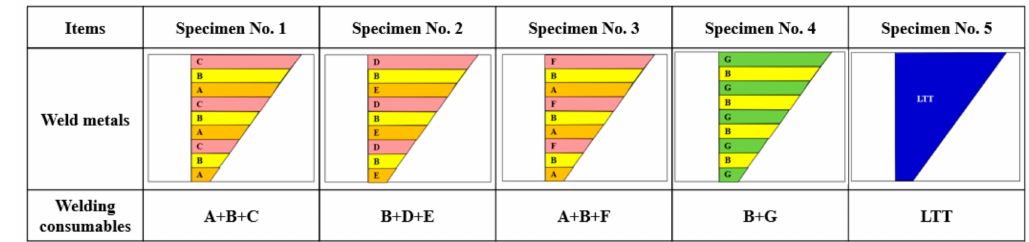
Figure 3. ESSO test specimen shape and dimension.